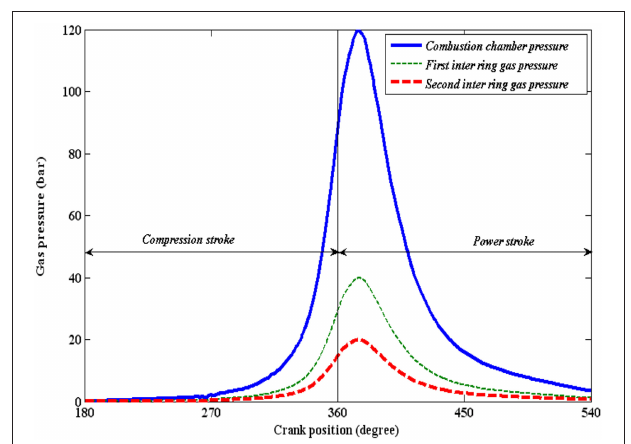
FIGURE 3 | Combustion chamber pressure and inter ring gas